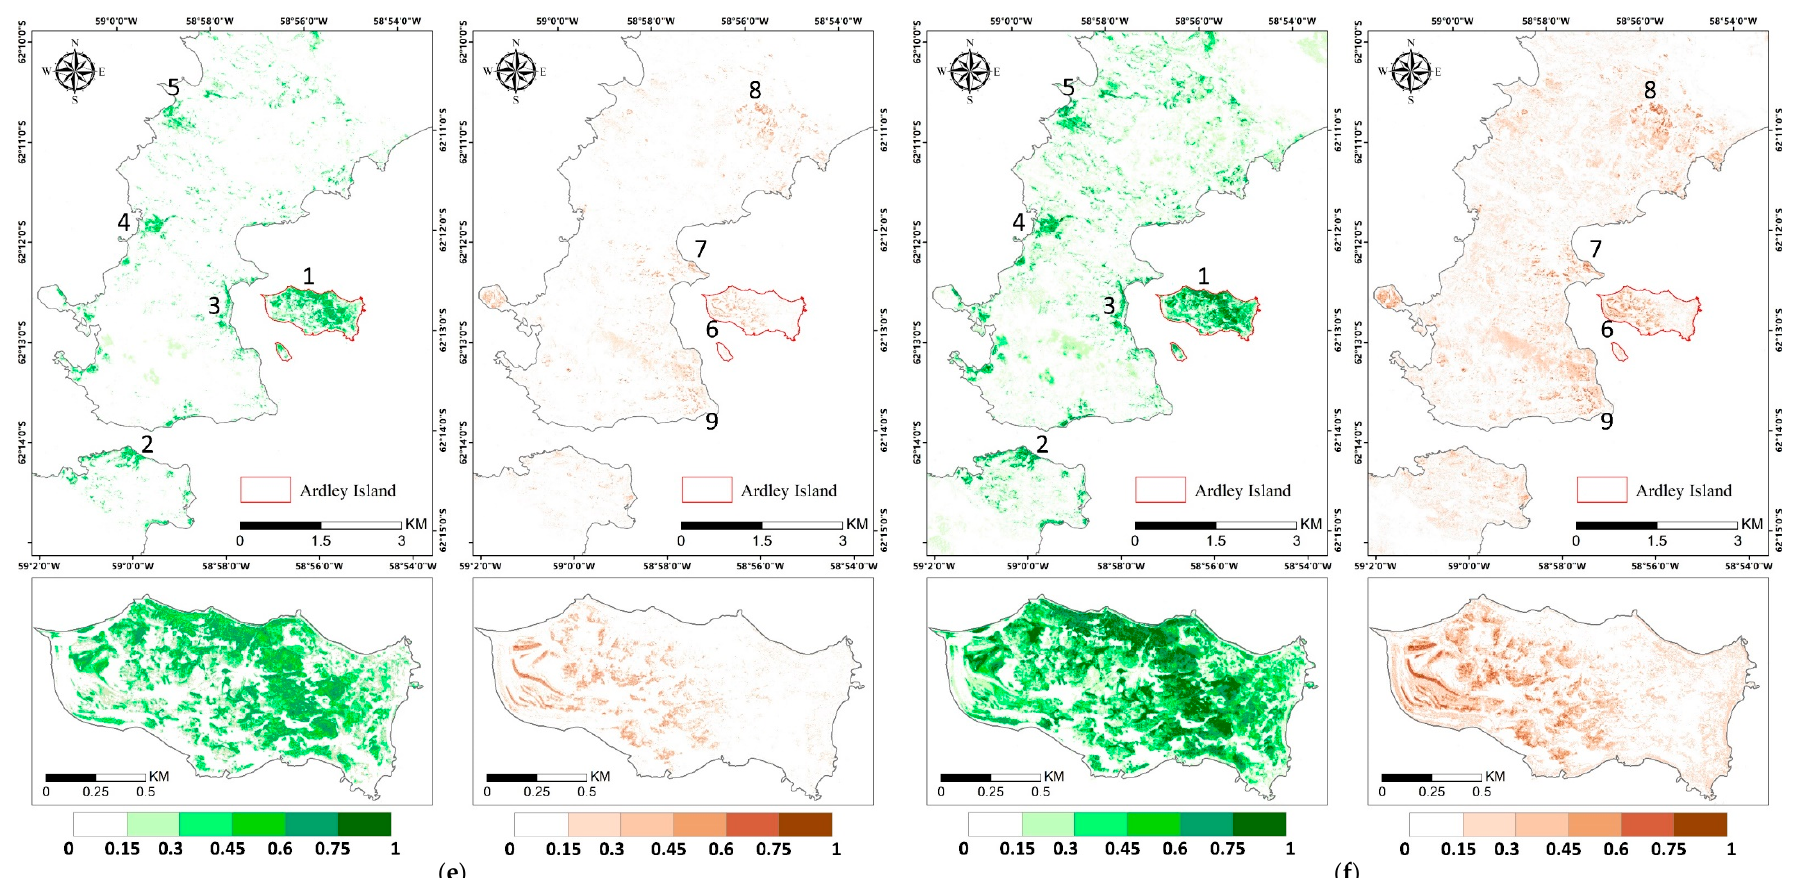
Figure A2. Vegetation abundance maps estimated with ( a ) Fully Constrained Least Square (FCLS), ( b ) Nascimento’s Model (NM), ( c ) Fan’s Model (FM), ( d ) Generalized Bilinear Model (GBM), ( e ) Modified Nascimento’s Models for Antarctic Vegetated areas 1 (MNM-AV1), and ( f ) Modified Nascimento’s Models for Antarctic Vegetated areas 2 (MNM-AV2). For each abundance result, the left panel shows the abundance of mosses, and the right panel shows that of lichens. Regions 1–5 represent high abundance regions of mosses, and regions 6–9 show high abundance regions of lichens.